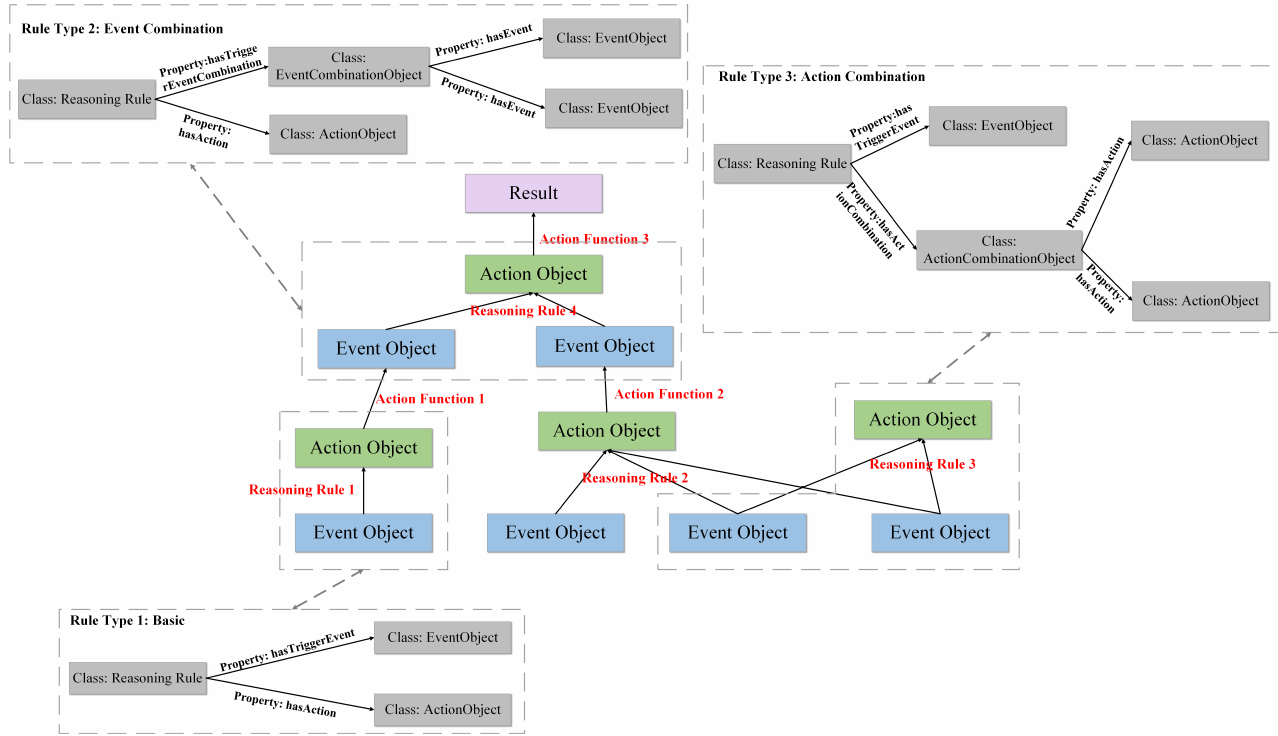
Figure 6. General reasoning program for semantic reasoning in each phase.